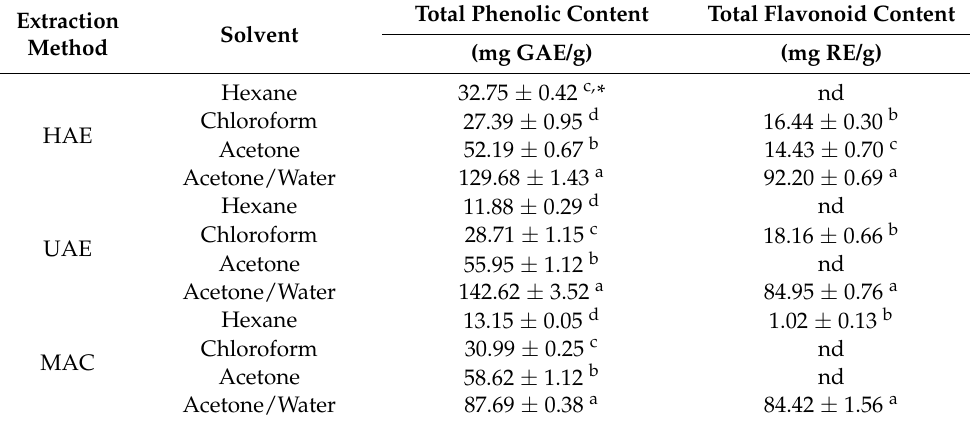
Table 1. Total phenolic and flavonoid contents in the tested extracts. Total Phenolic Extraction Solvent Method